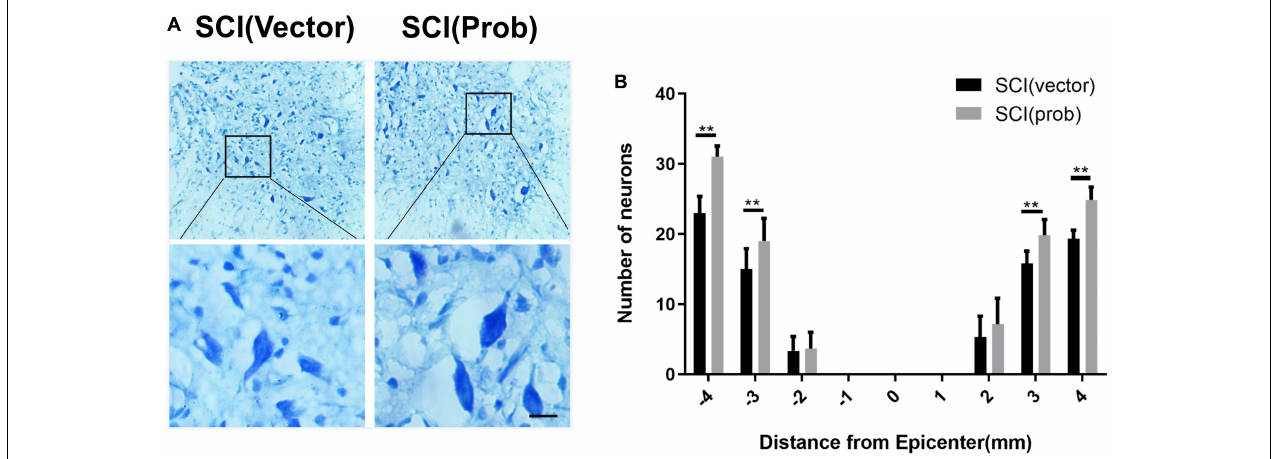
FIGURE 7 | Quantitative analysis of the effect of Probenecid on the number of residual ventral horn neurons. (A) Nissl-stained images of neurons in the ventral horn 3 mm rostral to the epicenter at 6 weeks post-SCI. Scale bar: 50 µ m. (B) Quantitative analysis of residual ventral horn neurons in different groups at different distances from the epicenter of the injury (0 mm) and 1, 2, 3, and 4 mm rostral (+) and caudal (–) from the epicenter. (** p < 0.01 n = 6).